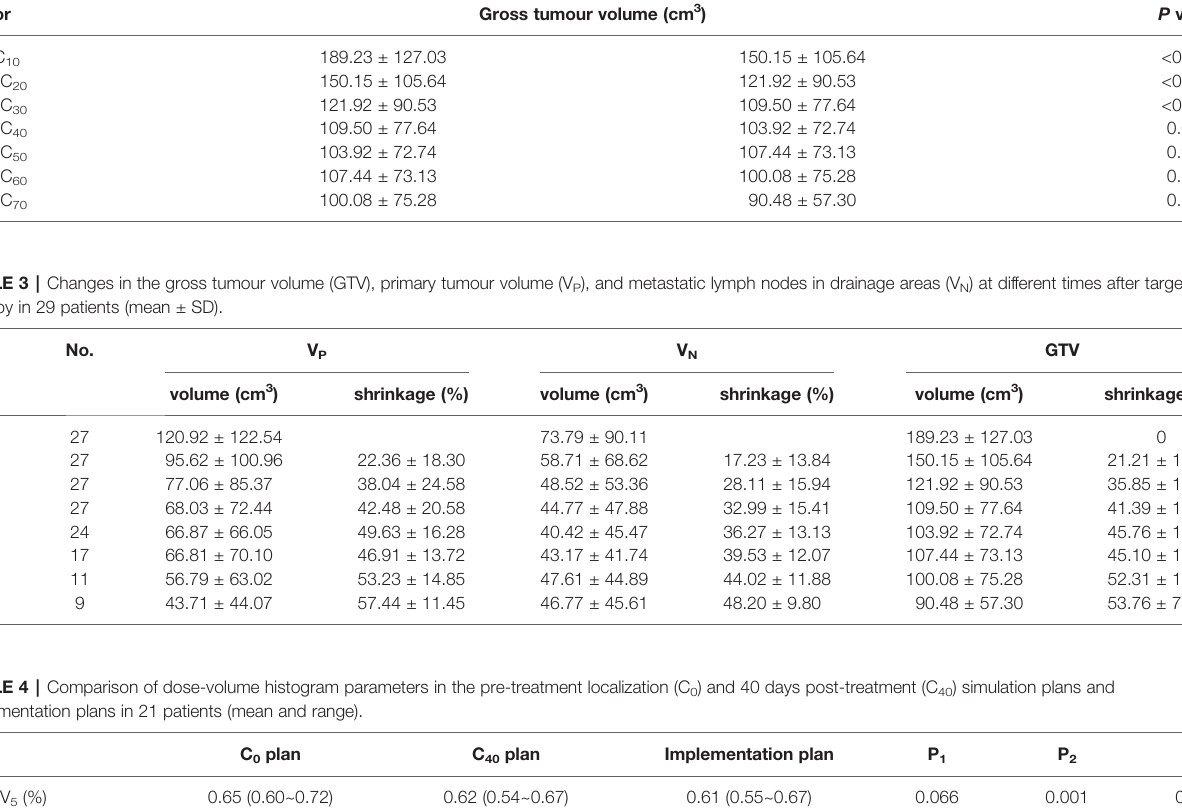
TABLE 2 | Comparison of the gross tumour volume (cm 3 ) every 10 days after targeted therapy in 27 patients. Factor